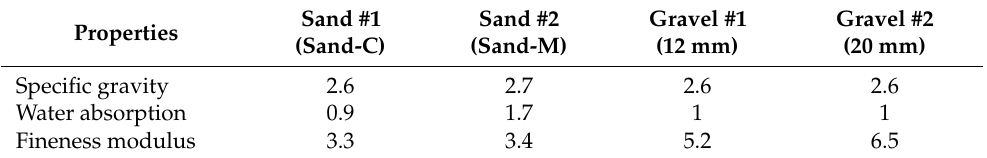
Table 3. Properties of